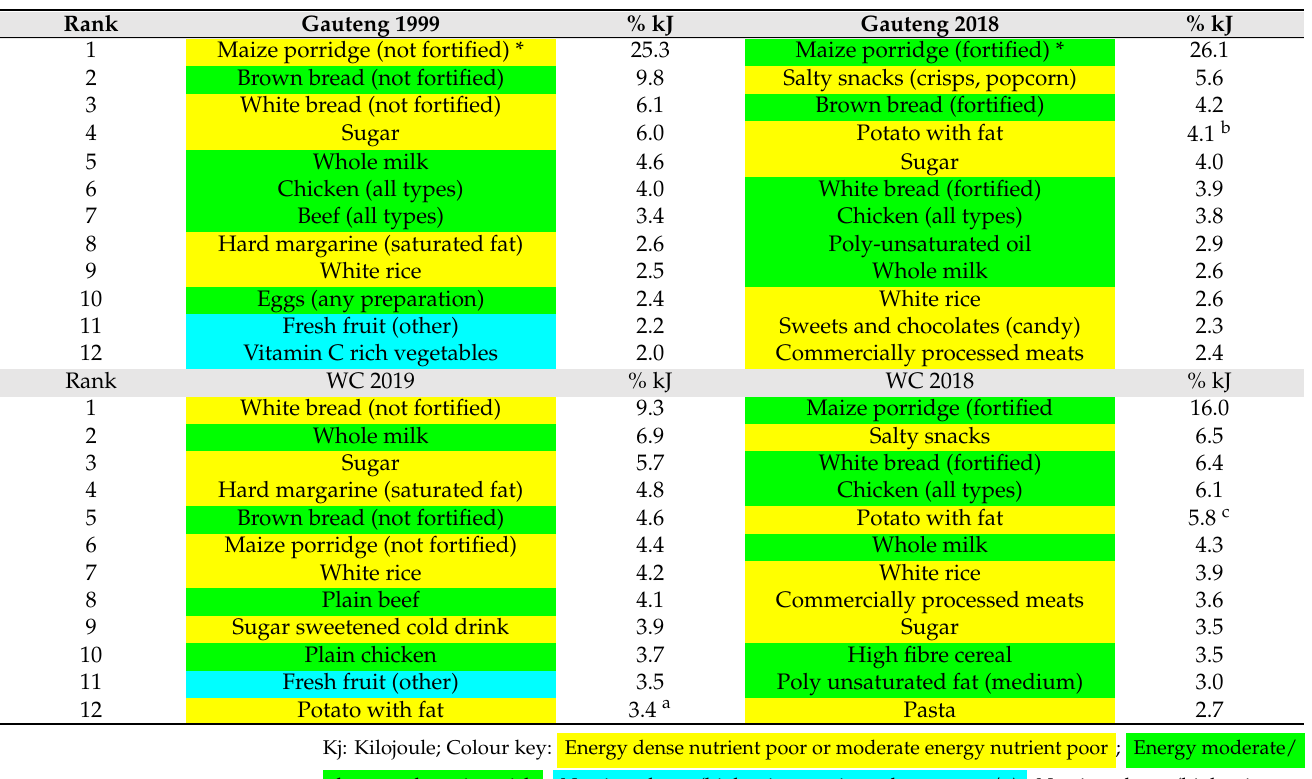
Table 6. Quality (nutrient density) of the top 12 food items contributing to the total energy intake of 1–<10-year-old children within Gauteng and the Western Cape, in 1999 and